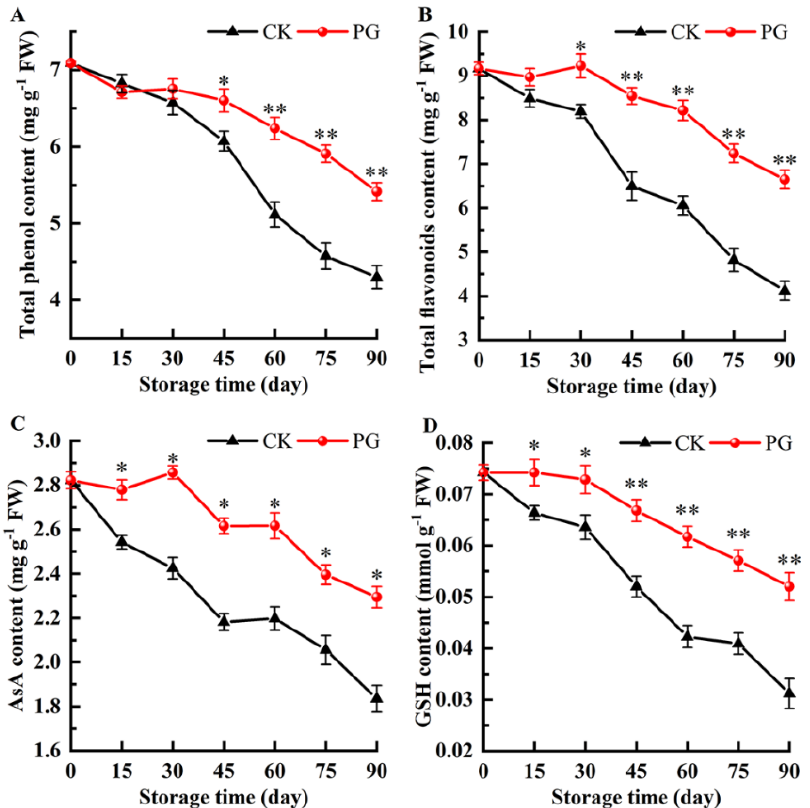
Figure 6. Effects of PG treatment on total phenols ( A ), total flavonoids ( B ), ascorbic acid (AsA) ( C ), and reduced glutathione (GSH) ( D ) in the peel. Vertical bars represent the SE of the mean. The asterisks indicate significant difference between two treatments during the same storage period (* p < 0.05, ** p < 0.01).